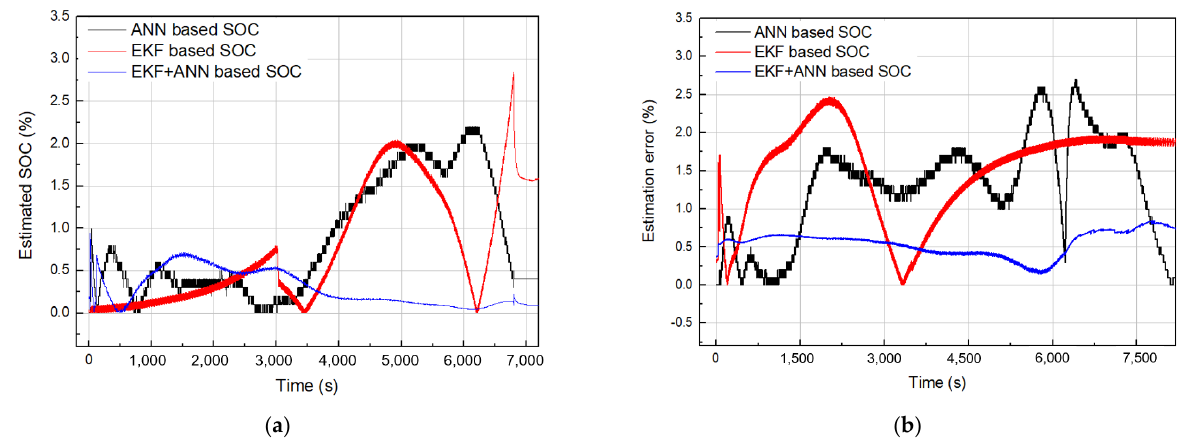
Figure 19. Errors of the SOC estimations using three methods: ( a ) Discharge; and ( b ) charge. Table 6. Summary of the errors in the SOC estimations using three methods.